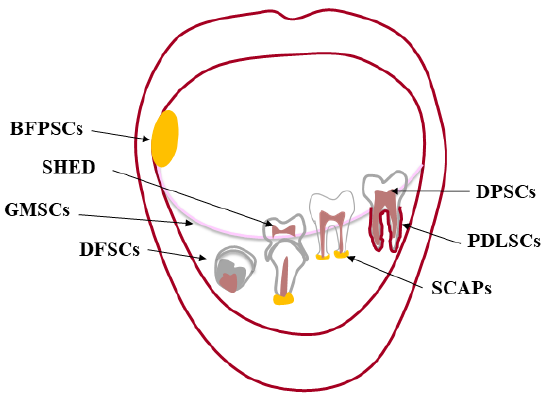
Figure 1. Oral cavity and its sources of dental MSCs. The oral (or buccal) cavity is the upper end of the alimentary canal in higher vertebrates bounded by “the lips anteriorly, the cheeks laterally, the palate superiorly, the floor of the mouth inferiorly, the oropharynx posteriorly”. The mandible and maxillae are the bony structures of the oral cavity to which the teeth articulate (gomphosis). Each tooth consists of two parts: one intraoral (the crown) and the other one endosseous (the root). The crown is made of enamel, mainly hydroxyapatite, and dentin forming the bulk of the tooth along with the dental pulp. This soft tissue providing blood supply and innervation is housed within the dentin from the tip of the root to the crown [20]. A layer of cementum covers the root, anchoring the tooth to its bony socket through the periodontal ligament. This sophisticated supporting structure along with the gingiva adjacent to the tooth is called periodontium. In the oral cavity, there are different sources of MSCs: dental pulp stem cells (DPSCs); pulp tissue of exfoliated deciduous teeth (SHED); periodontal ligament (PDLSCs); apical papilla of developing teeth (APSCs); dental follicle (DFSCs) and gingiva (GFSCs); buccal fat pad (BFPSCs).